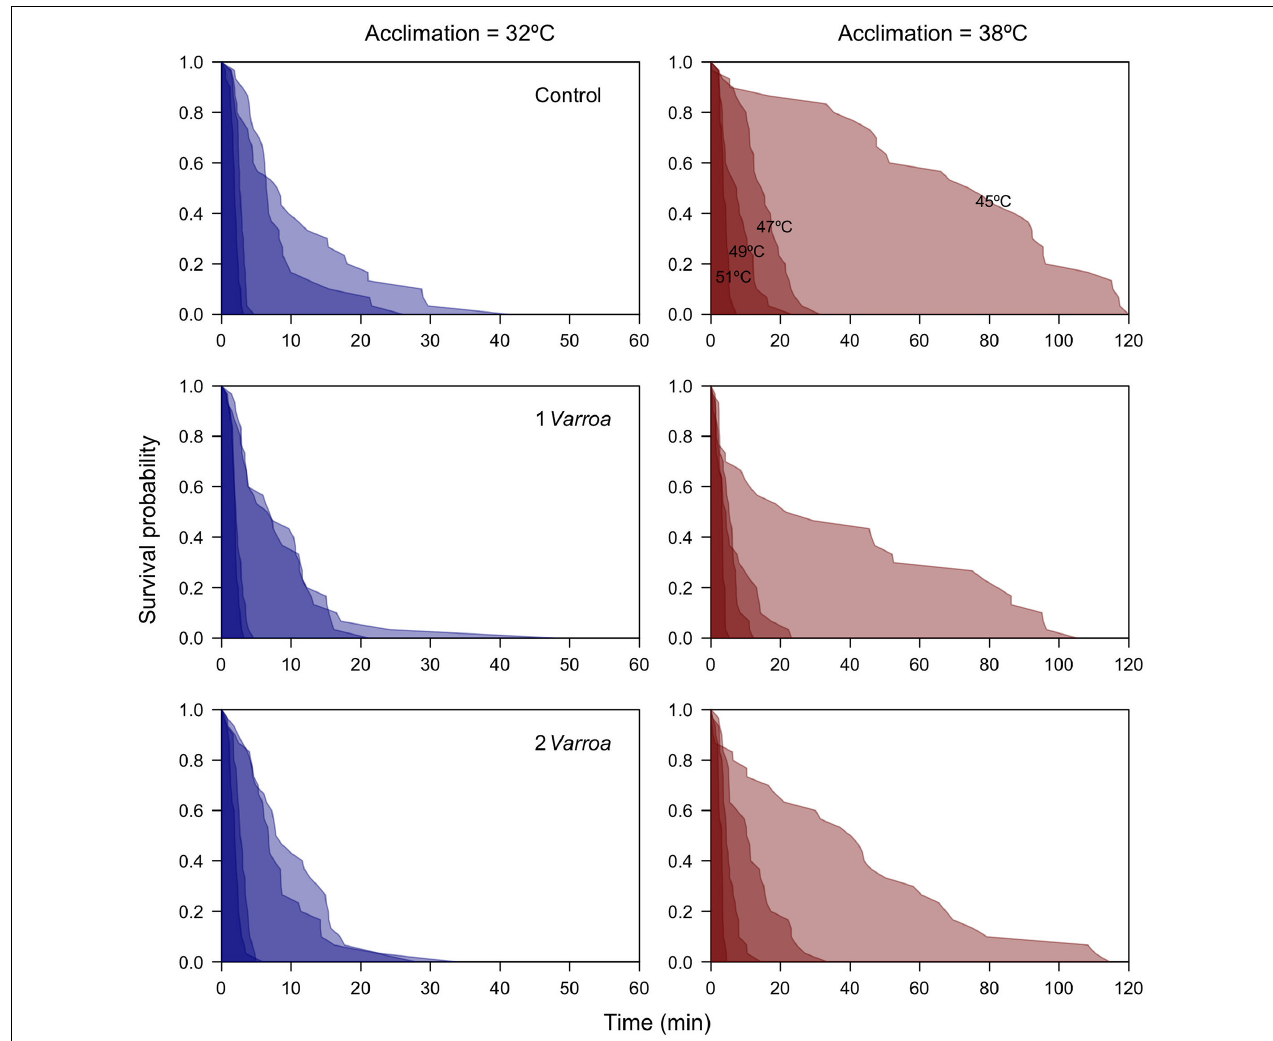
FIGURE 1 | Survival curves obtained at different temperatures for honeybees acclimated to 32 and 38 ◦ C, and subjected to different levels of parasitism by Varroa (0, 1, and 2 mites). Measurements involved a total n = 720 individuals ( n = 120 per